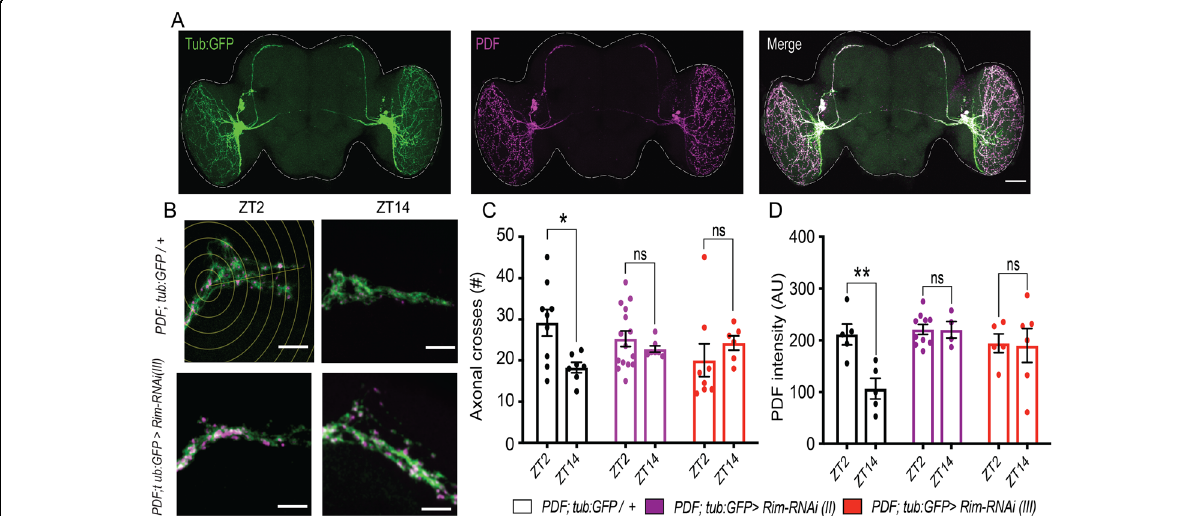
Fig. 4 Day/night remodelling of dorsal s-LNvs terminals and PDF availability were removed by Rim knockdown. A PDF-GAL4 driven expression of a GFP-tagged version of tubulin (Tub:GFP) was used to label all the neuronal processes of LNvs. Tub:GFP (green) can be observed in the terminals, axons and somas of LNvs (left panel). Immunodetection of PDF is shown in magenta (middle panel). Merged images show colocalization of l-LNvs terminals and PDF immunoreactive signals (right panel). Scale bar represents 50 μ m. B Representative images of s-LNvs dorsal terminals during daytime (ZT2, i.e. 11 a.m.) and night (ZT14, i.e. 11 p.m.) in control fl ies (top panels) and PDF; tub:GFP>Rim-RNAi (bottom panels). Scale bars show 10 μ m. White lines in the upper left panel in B represent the circles used for Sholl analysis. C Analysis revealed that there were signi fi cantly more axonal crosses for control fl ies at day than at night (open black bars). This day/night difference in terminal complexity was not observed in the PDF>Rim-RNAi fl ies (purple and red bars show results using two independent RNAi lines). D PDF was also found to be cycling in control fl ies (open black bars), with high levels during the day (ZT2) and reduced levels at night (ZT14) as measured by the mean intensity of each PDF cluster. This day/night difference in PDF accumulation was not detected in PDF>Rim-RNAi fl ies (purple and red bars), which remained in a perpetually high state. Data in C and D were analysed using two-way ANOVA with Sidak ’ s post hoc ( PDF; tub:GFP / + ) = 7 – 9 brains, n ( PDF; tub:GFP>Rim-RNAi (II) ) = 7 – 15 brains, n ( PDF; tub: GFP>Rim-RNAi (III) ) = 8 – 6